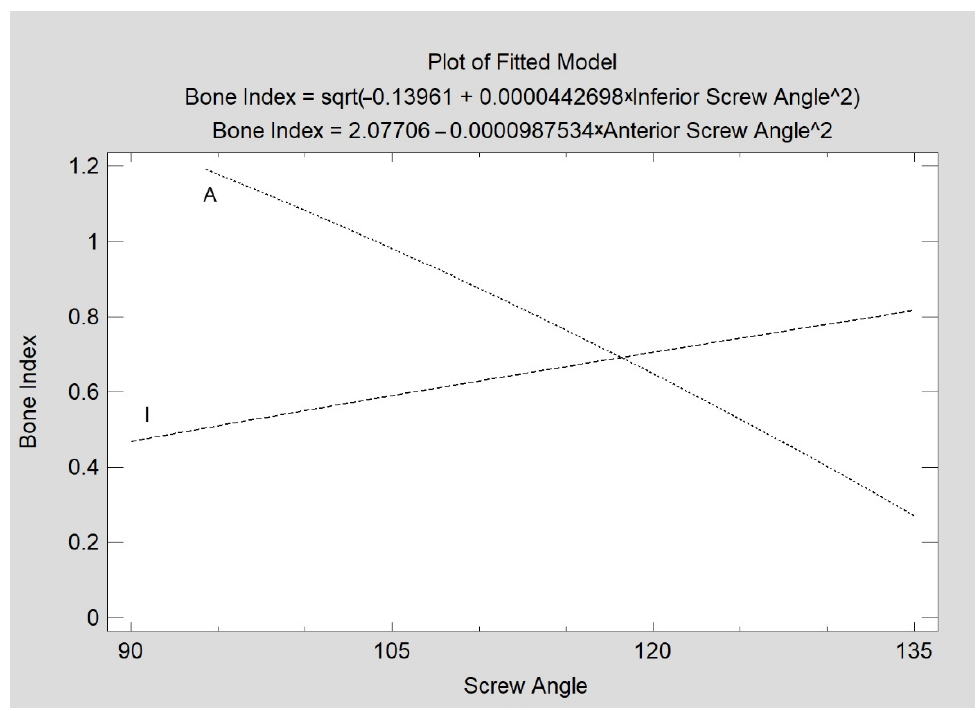
Figure 9. The relationship between the consolidation quality (Bone Index) and the screw insertion angle was observed. Statistically significant relations ( p < 0.05) were found for the inferior screw (I) and for the anterior screw (A).